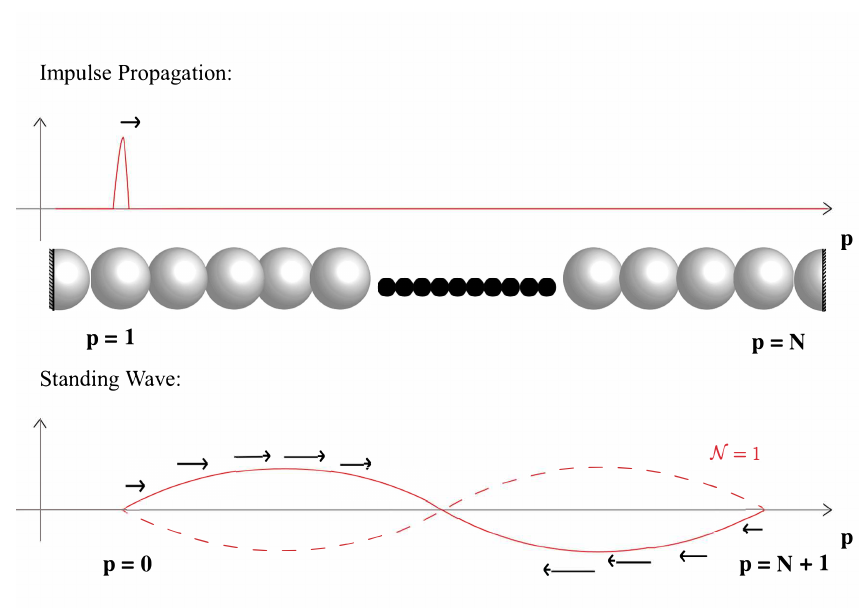
Figure 1. Impulse and (sinusoidal) standing wave initial conditions for a fixed-end and periodic granular chain,